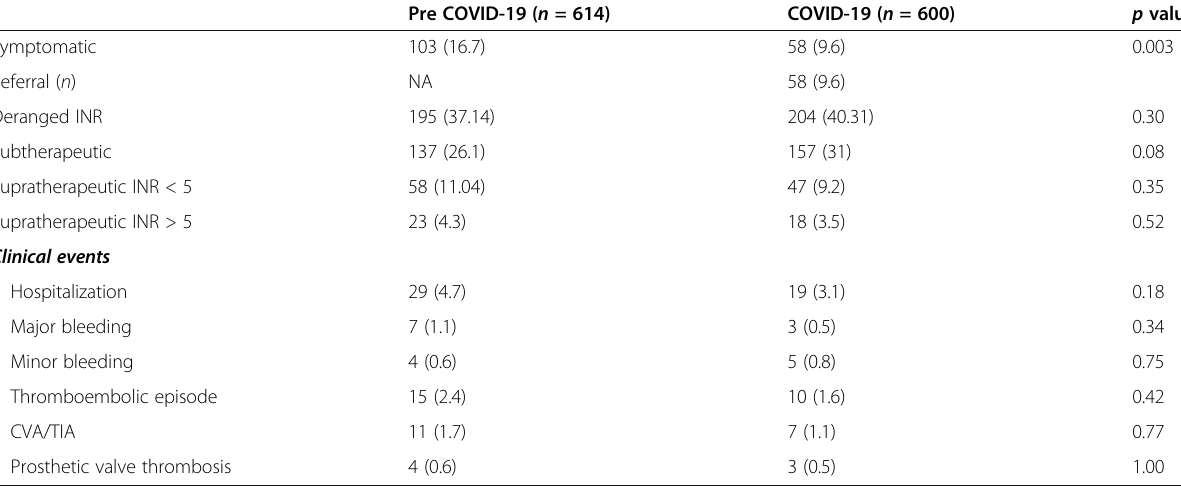
Table 2 Symptomatic patients in pre-COVID-19 versus COVID-19 phase Pre COVID-19 ( n = 614) COVID-19 ( n = 600) 103